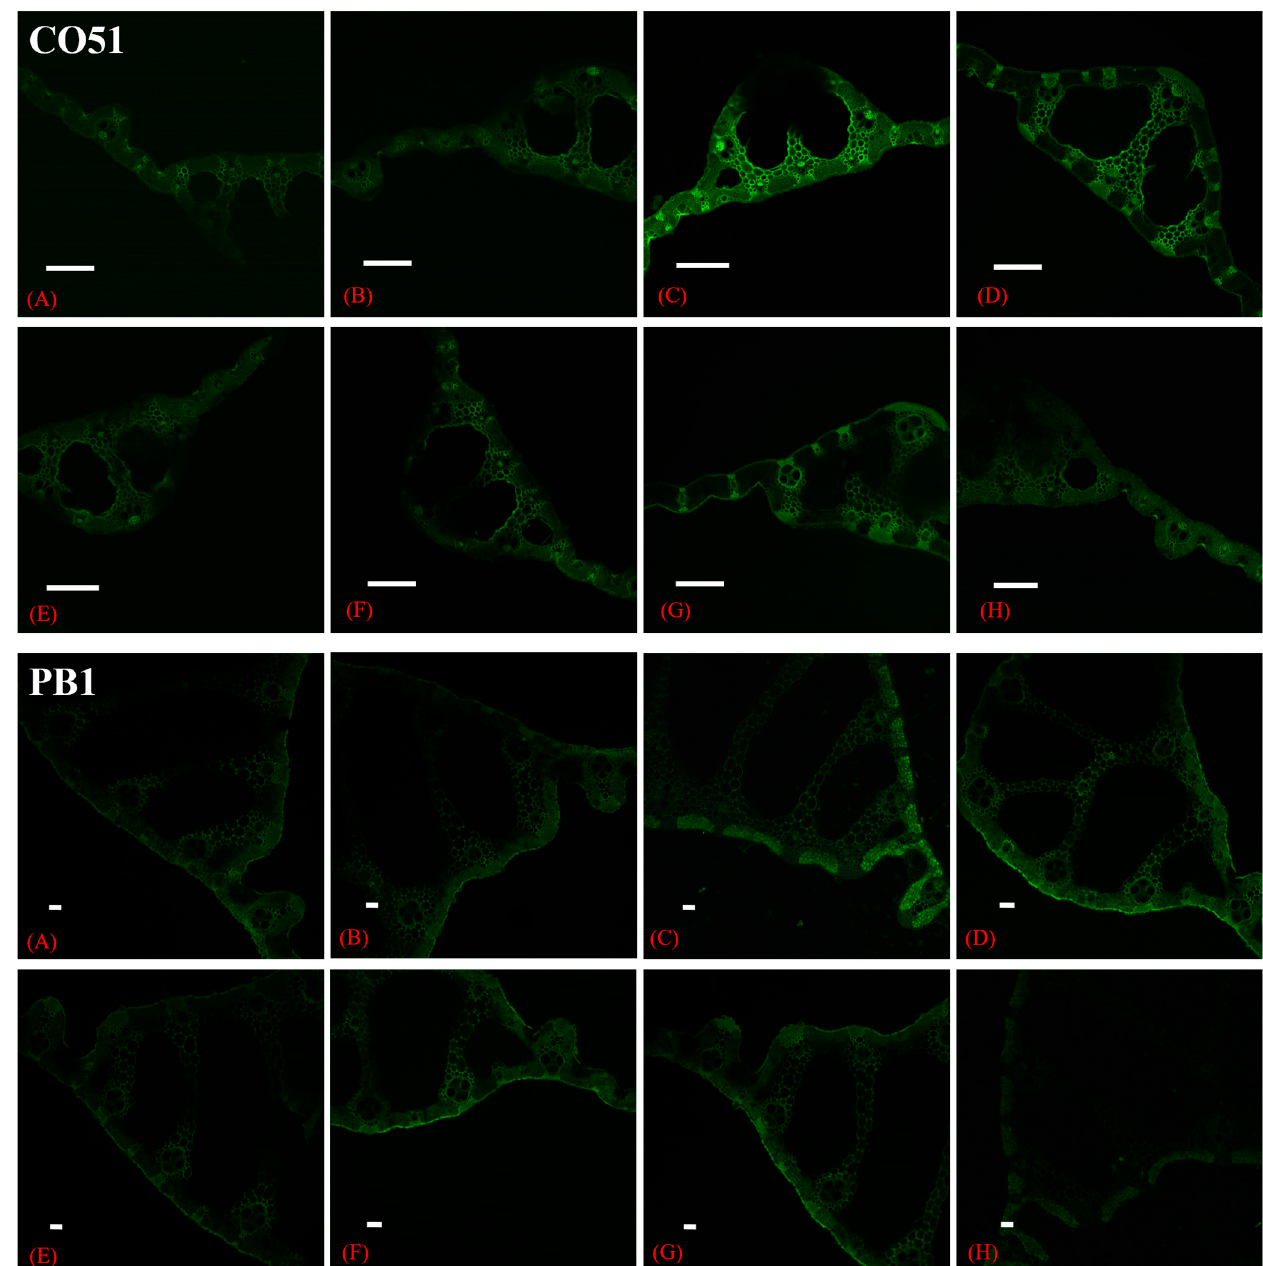
Figure 6. Confocal scanning laser microscopic images showing the difference in sodium accumula- tion in cross sections of CO51 and PB1 rice leaves. ( A , B ) Negative control, ( C ) Positive control (200 mM NaCl), ( D ) 200 mM NaCl + Trichoderma viride , ( E ) 200 mM NaCl + Bacillus haynesii 2P2, ( F ) 200 mM NaCl + Bacillus safensis BTL5, ( G ) 200 mM NaCl + Brevibacterium frigoritolerans W19, and ( H ) 200 mM NaCl + Pseudomonas fluorescens . Scale bar = 50 µm.